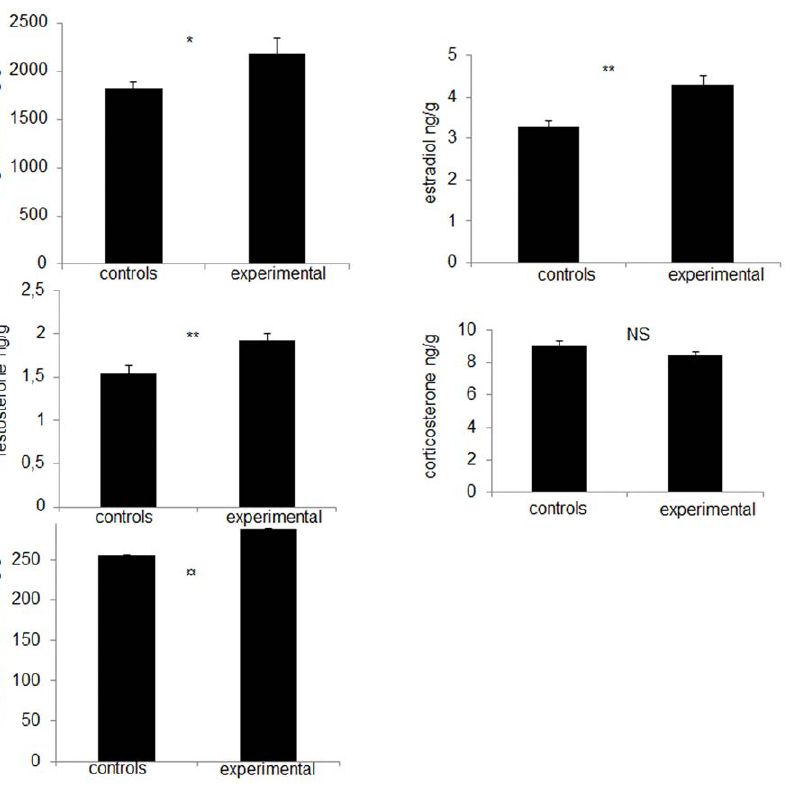
Figure 3. Yolk steroid levels in the eggs from control (N=20) and experimental hens (N=20). Mean 6 SEM progesterone (P4), testosterone (T), androstenedione (A4), estradiol and corticosterone concentrations (ng/g of yolk) in the eggs of laying hens maintained under a standard thermal condition (21 u C) or under a warm temperature (30 u C) for 5 weeks. ANOVAs, * P , 0.05; ** P , 0.01; ¤ 0.05 , P , 0.1; NS, P . 0.05.